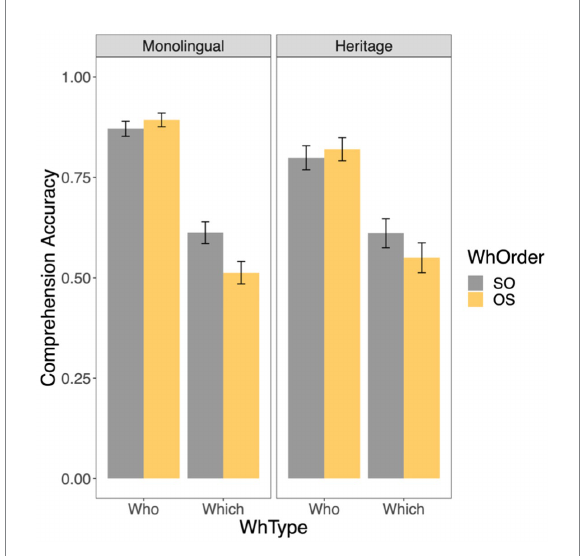
FIGURE 1 Mean accuracy scores (with standard error bars) for multiple wh-questions per group (Monolingual vs. Heritage) per wh-type ( who vs. which ) per wh-order (SO vs.